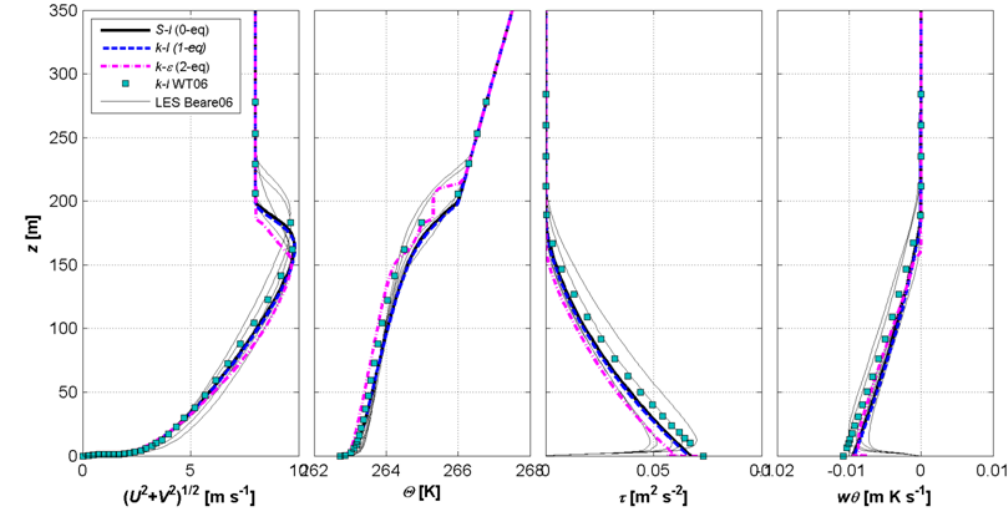
Figure 2. GABLS1 quasi-steady vertical profiles of horizontal wind speed S = ( U 2 + V 2 ) 1 / 2 , potential temperature (cid:50) , shear stress τ and kinematic heat flux w(cid:50) . Comparison between SCM simulations using three turbulent closures ( S - l , k - l and k - ε ) and the k - l model of Weng and Taylor (2006) and the LES simulations of Beare et al.